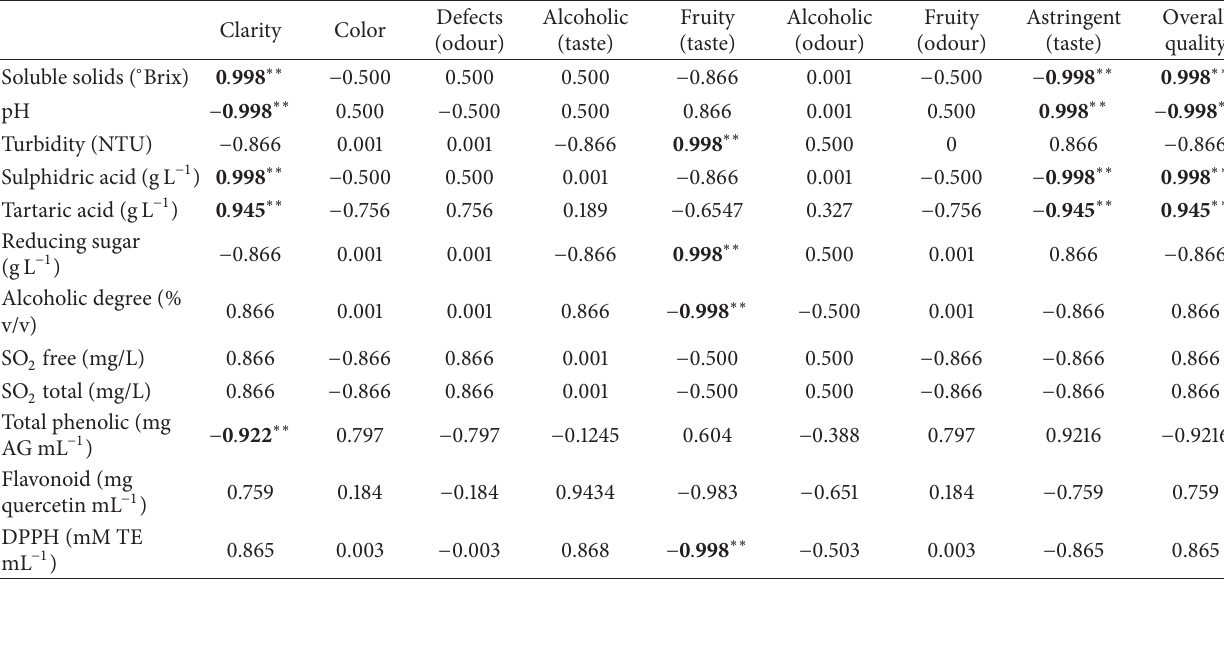
Table 7: Correlation coefficients between physicochemical and sensory characteristics of white wine treated at 500 MPa. Clarity Color